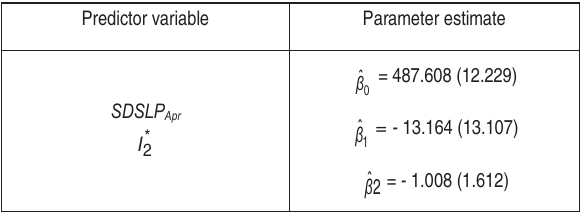
Table 4. Correlations analysis between summer Table 5. Parameter estimates for regression model (standard errors in brackets)